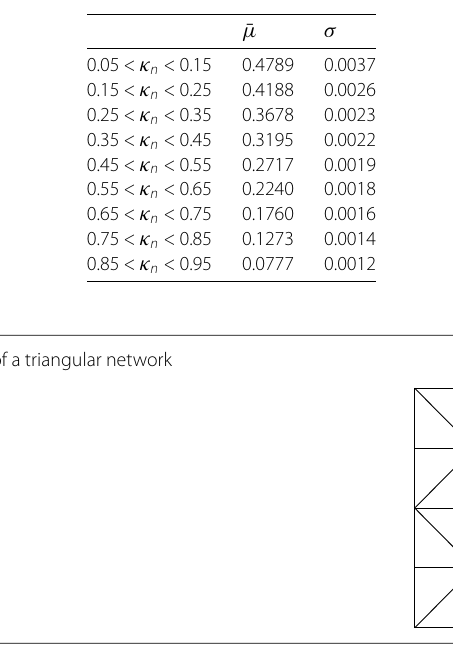
Table 1 The mean ¯ μ and the standard deviation σ of the distribution of f c for the rectangular network